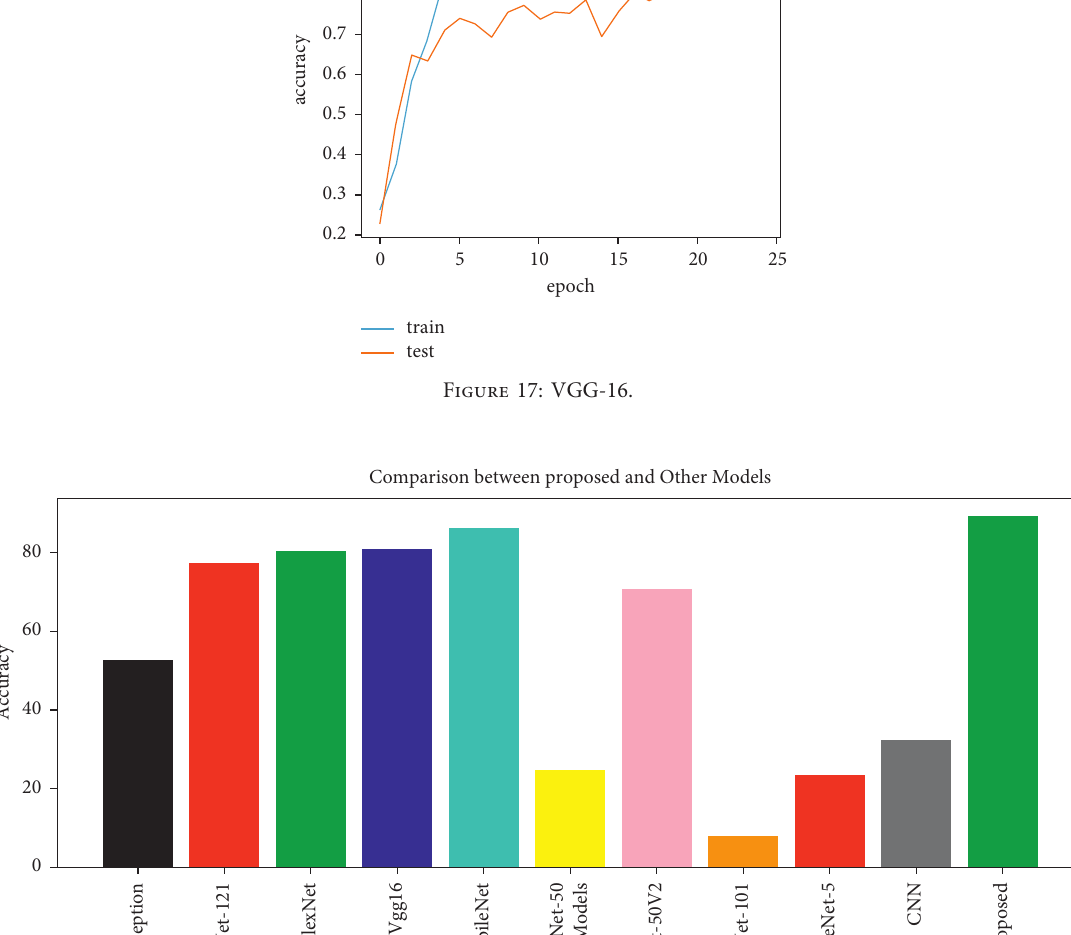
Figure 16: ResNet-101.